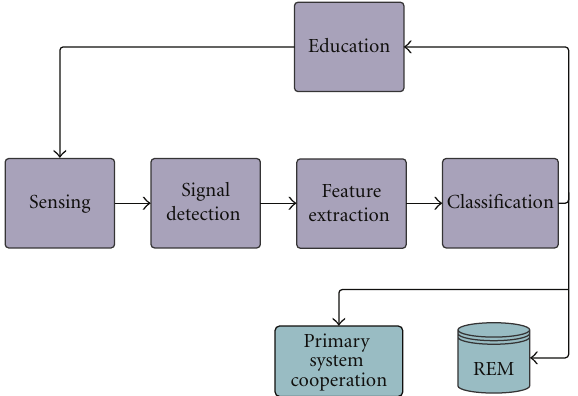
Figure 4: PHY mode identification and classification work-flow. Figure 5: Processing chain with a common wideband receiver (WBR), transmission class-specific subsystems for pattern extrac- tion (PE) and for integrated detection and classification